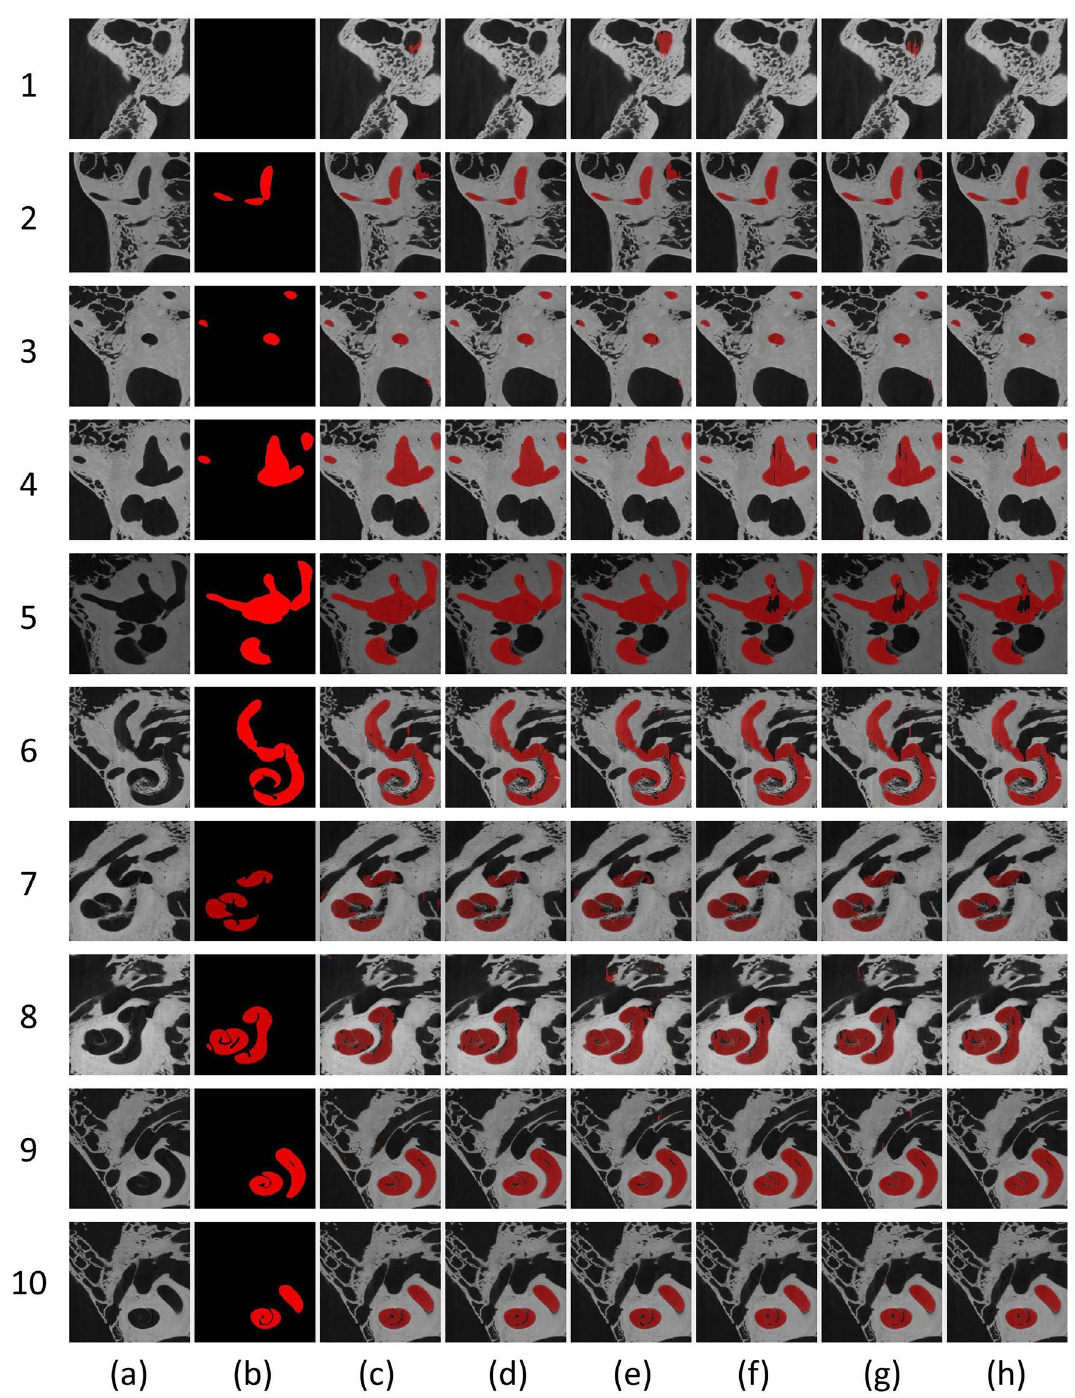
Figure 4. Qualitative segmentation results. (a) Original input image slices, (b) groundtruth labels, (c) U-Net, (d) AutoCasU-Net, (e) ResU-Net, (f) AutoCasResU-Net, (g) SEU-Net, (h)